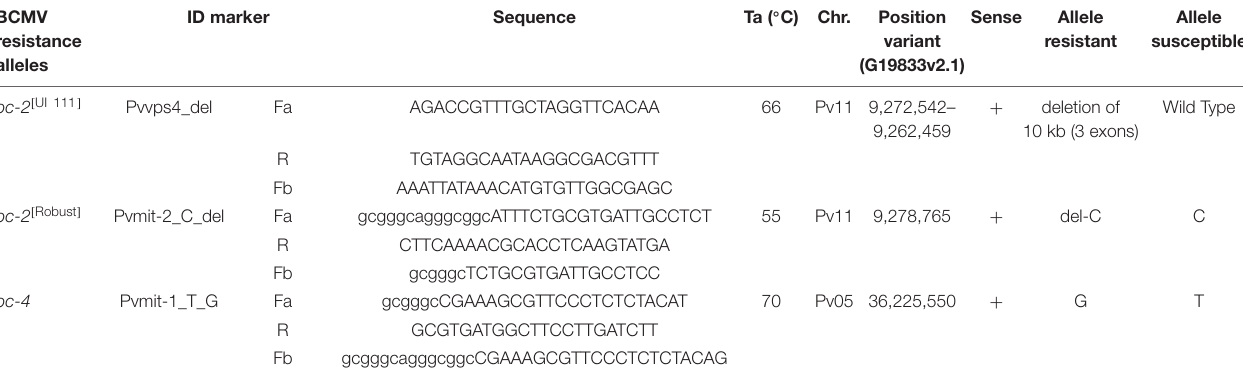
TABLE 2 | Primers used to generate markers for bc-2 [ UI 111 ] , bc-2 [ Robust ] , and bc-4 alleles. BCMV ID resistance alleles